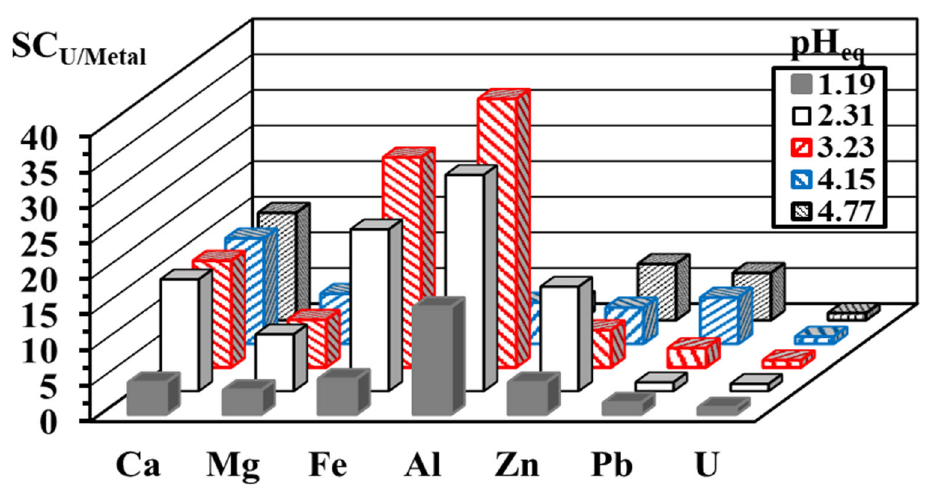
Figure 11. Selectivity studies of uranium sorption from acidic ore leachate.